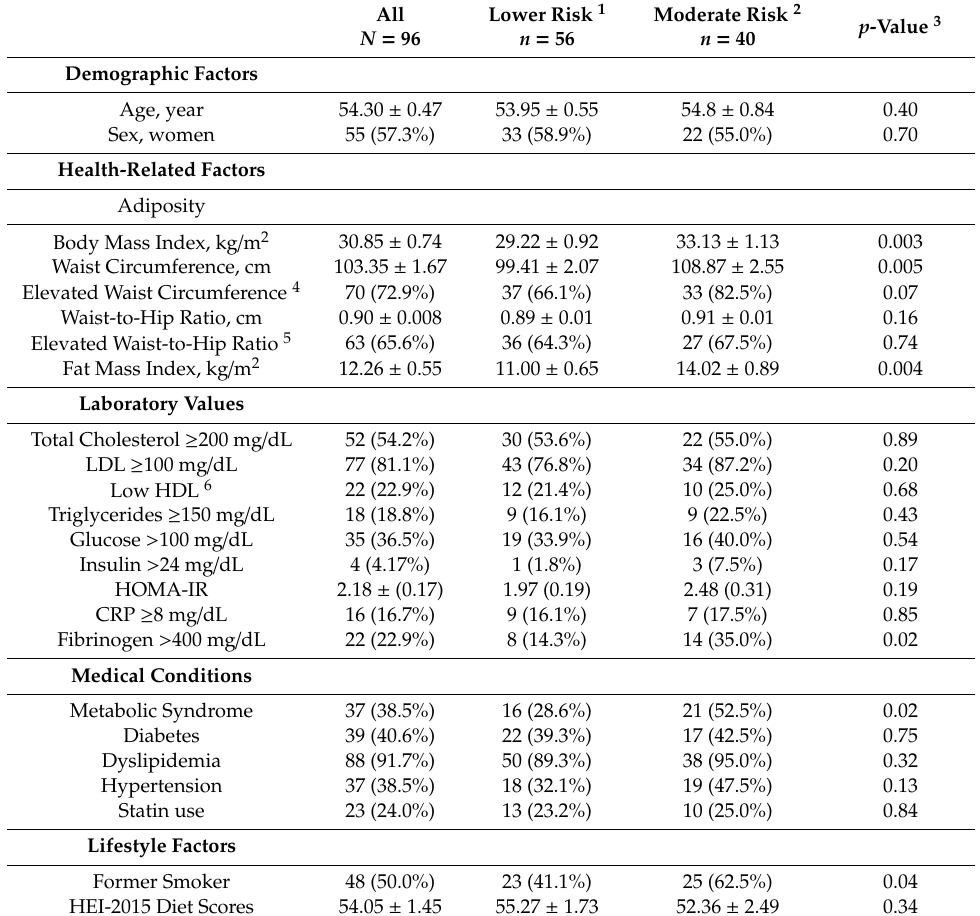
Table 1. Participant characteristics by ceramide risk